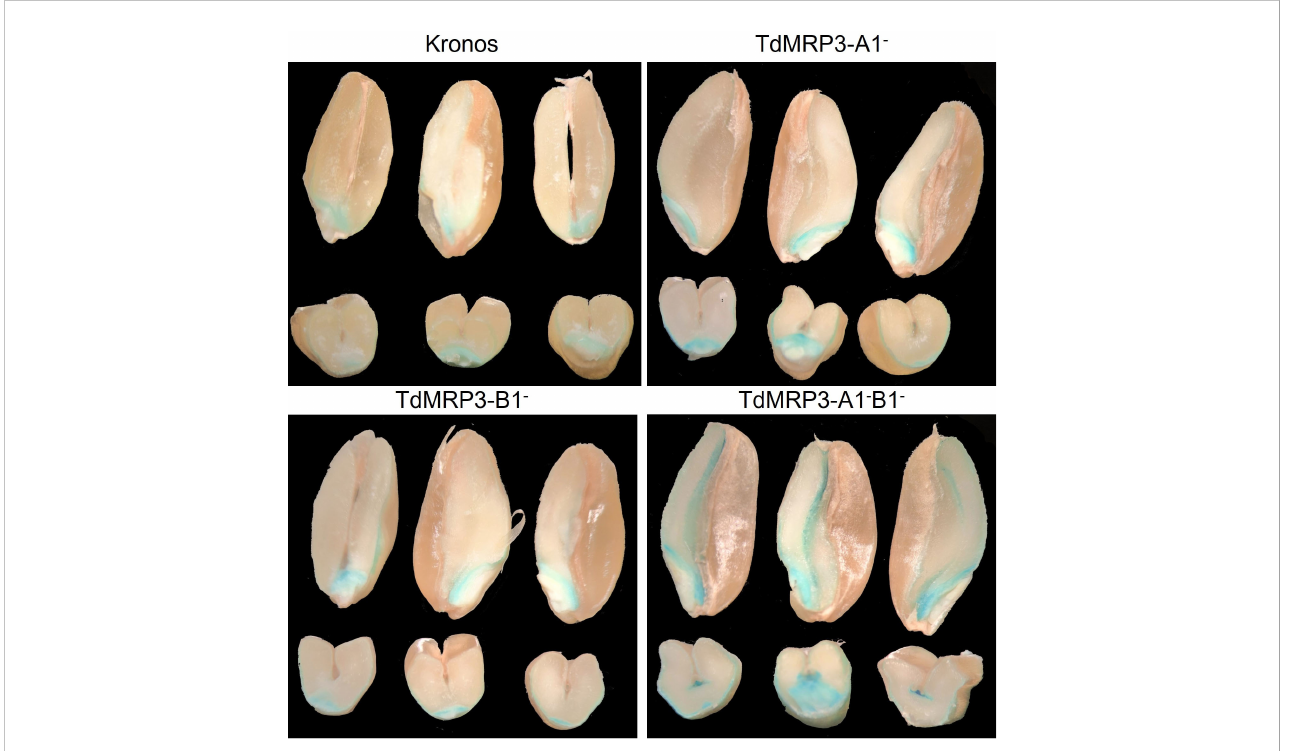
FIGURE 3 Visualization of iron deposits within the kernel using the Perls staining. In each image there are the longitudinal sections (top) and the transversal sections (bottom), of the seeds of cv. Kronos, TdMRP3-A1 - , TdMRP3-B1 - , TdMRP3-A1 - B1 - .